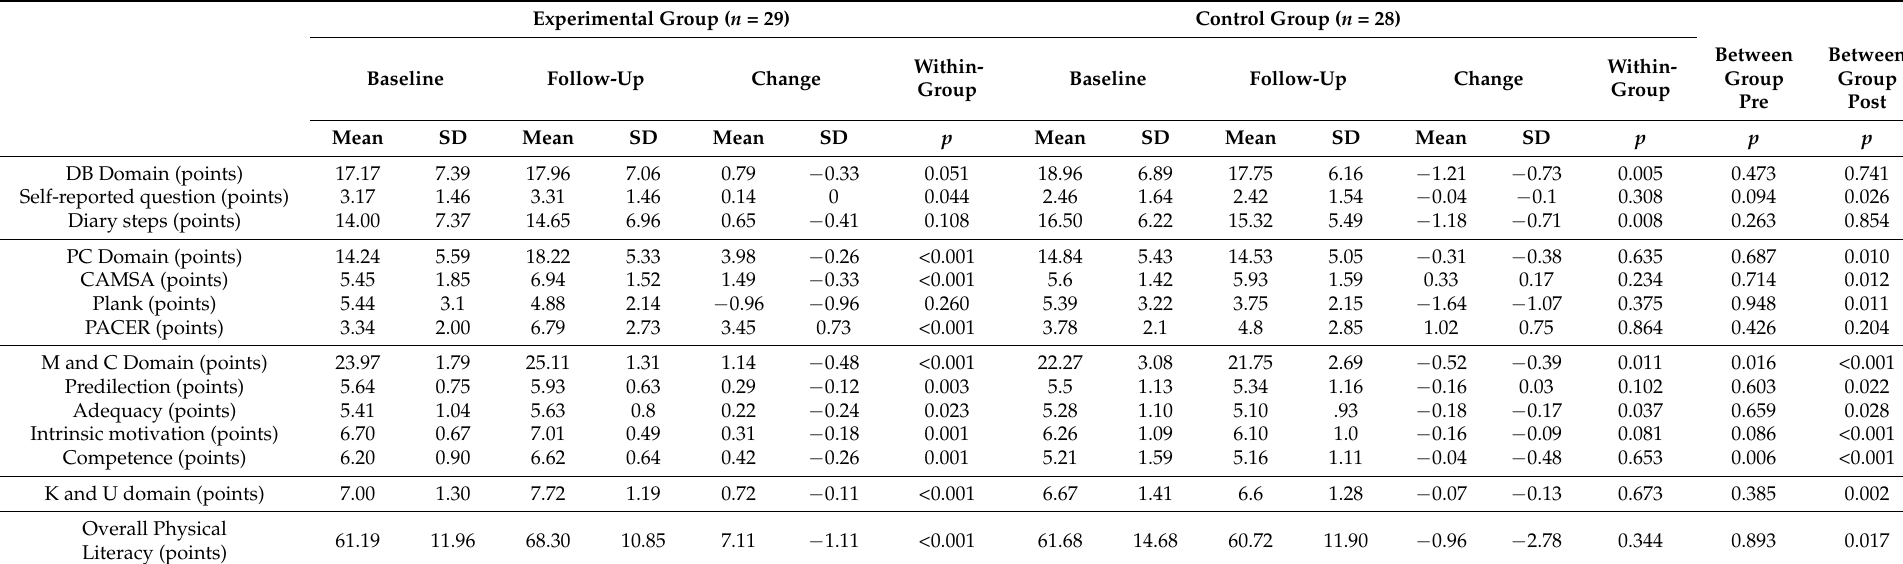
Table 3. Outcome of physical literacy measures at baseline, follow-up and changes at 4